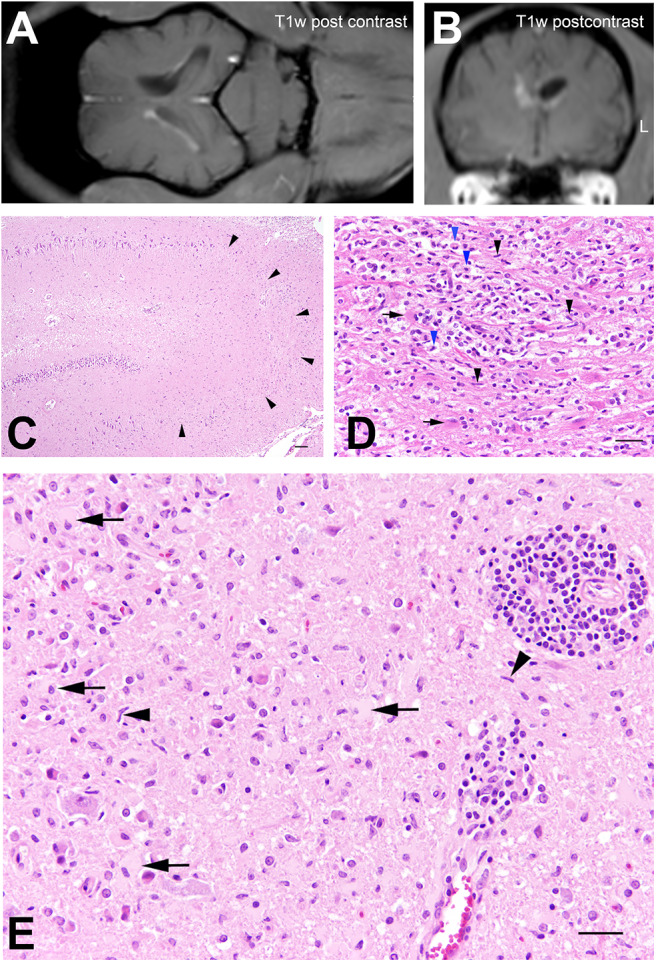
Cat no. 3. (A,B) Magnetic resonance imaging (MRI): Dorsal (A) and transversal section (B) of the brain at the level of the interthalamic adhesion in T1w sequences post-contrast application. Note the small rim of contrast enhancement in the lateral ependymal lining of the right lateral ventricle and the slightly decreased volume of the right lateral ventricle. Left side is marked with L. (C–F) Histopathology. (C) Hippocampus with severe neuronal loss in the CA2 and CA3 regions (arrowheads). HE, bar = 100 μm. (D) Periventricular white matter with severe microgliosis (black arrowheads), infiltration of gitter cells (blue arrowheads) and gemistocytes (arrows). HE, bar = 50 μm. (E) Brain stem, moderate lympho-histiocytic perivascular encephalitis with prominent microgliosis (arrowheads), astrocytosis and presence of gemistocytes (arrows). HE, bar = 60 μm.